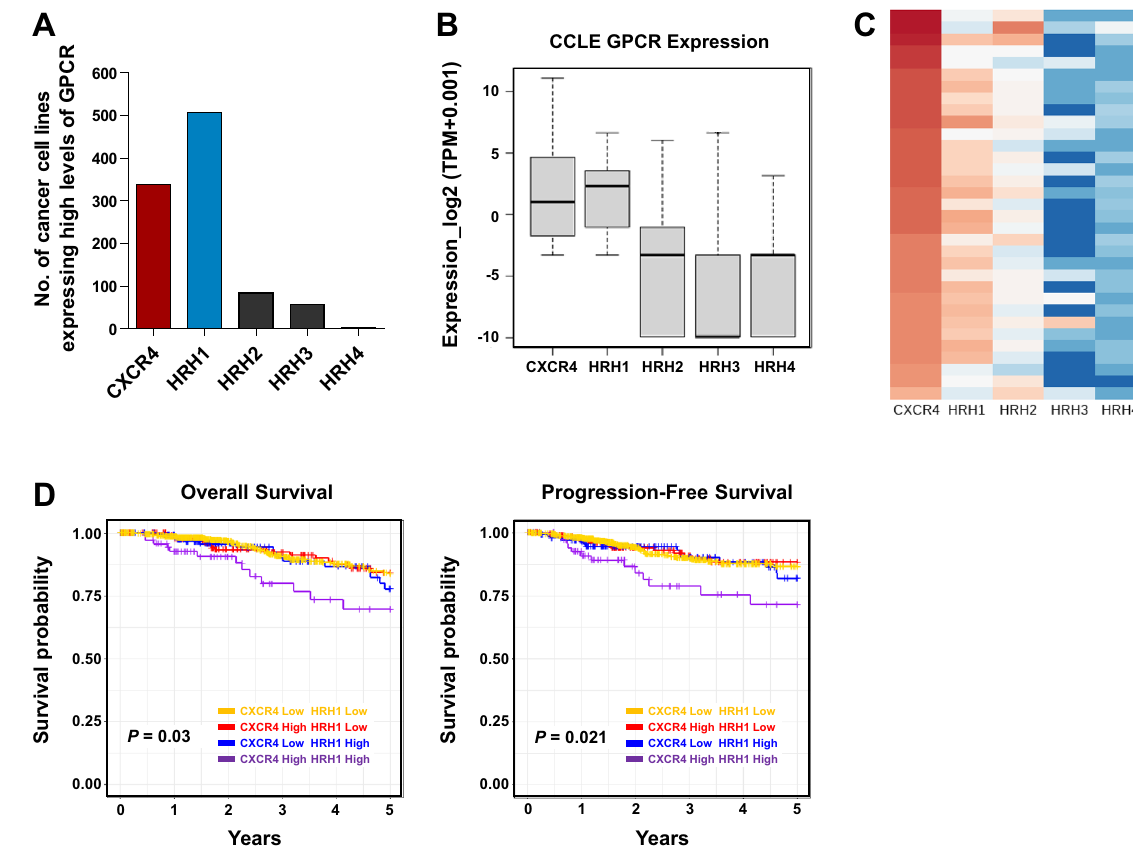
Figure 1. Coexpression of CXCR4 and HRH1 in breast cancers correlates with poor patient prognosis. ( A ) Expression of CXCR4 and histamine receptor subtypes in cancer cell lines based on RNA-seq data from the CCLE. Cancer cell lines expressing CXCR4, HRH1, HRH2, HRH3, and HRH4 mRNAs higher than 5 TPM were counted. ( B ) Box plots of the expression levels of CXCR4 and histamine receptors in cancer cell